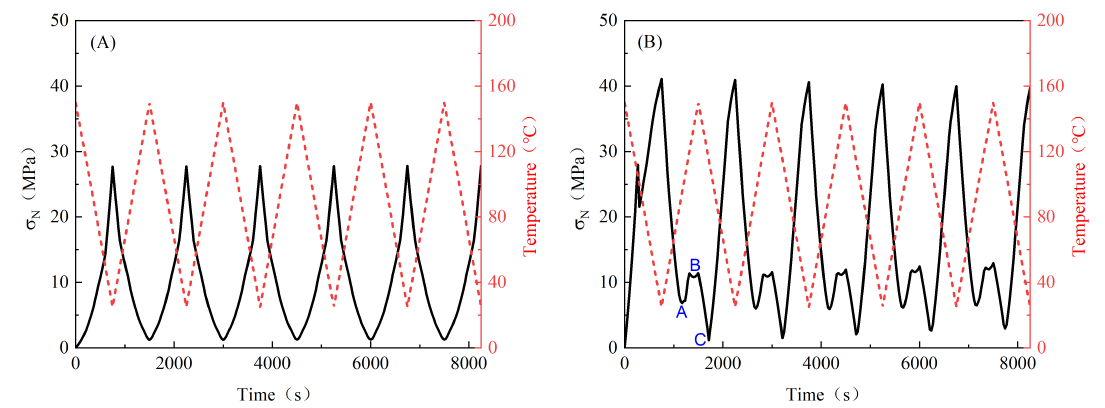
Figure 5. Stress evolution at N-point of model II under the ( A ) fixed constraint and ( B ) non- fixed